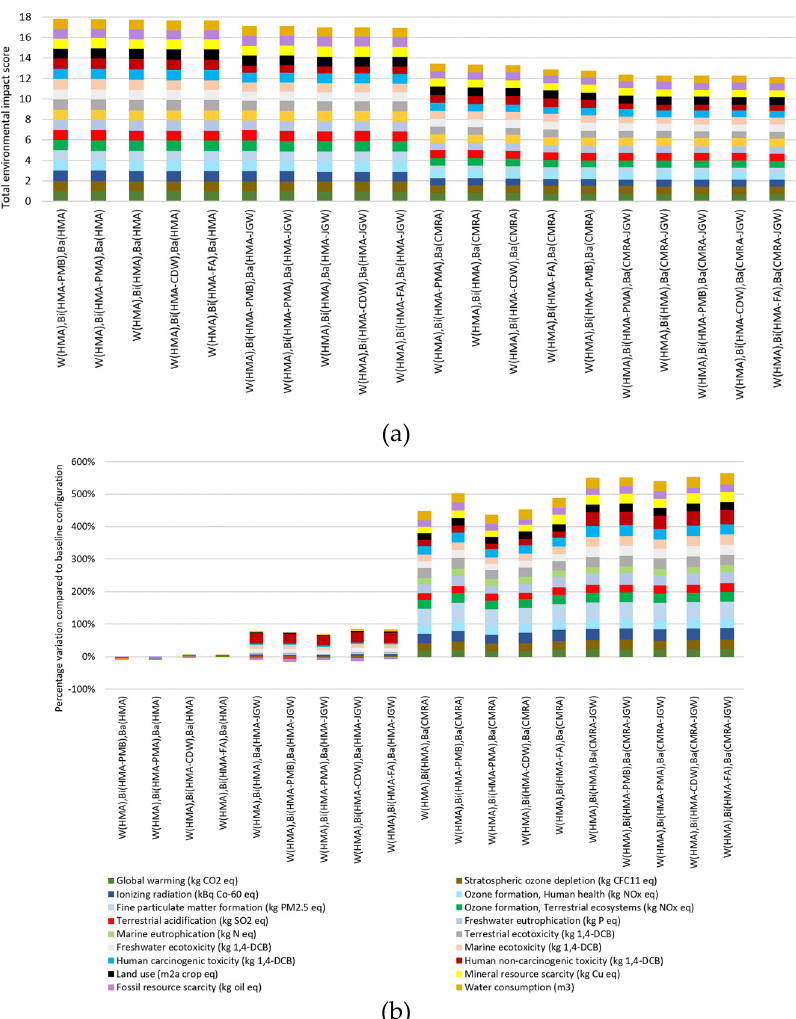
Figure 3. ( a ) Total environmental impact score, calculated as the sum of the normalized impact category indicators, for each pavement configuration and ( b ) percentage variations of each impact category indicator of the pavement configurations compared to the baseline pavement configuration in traditional HMA.